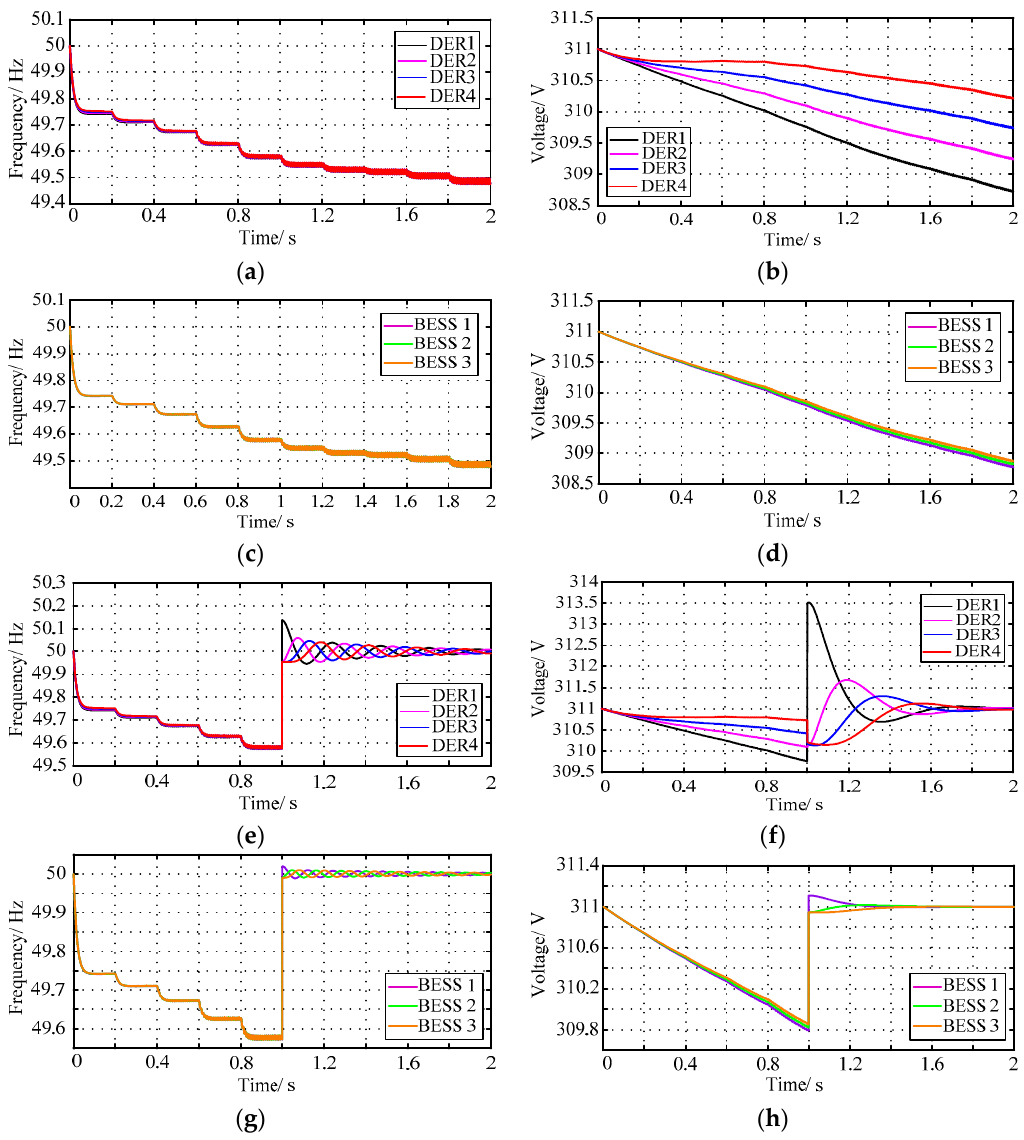
Figure 11. Variations of output voltage and frequency of PVs and BESSs when load is changed in different time periods; ( a ) The frequency variations of PVs under the action of droop control; ( b ) The voltage variations of PVs under the action of droop control; ( c ) The frequency variations of BESSs under the action of drop control; ( d ) The voltage variations of BESSs under the action of droop control; ( e ) The frequency variations of PVs under the action of secondary control; ( f ) The voltage variations of PV s under the action of secondary control; ( g ) The frequency variations of BESSs under the action of secondary control; ( h ) The voltage variations of BESSs under the action of secondary